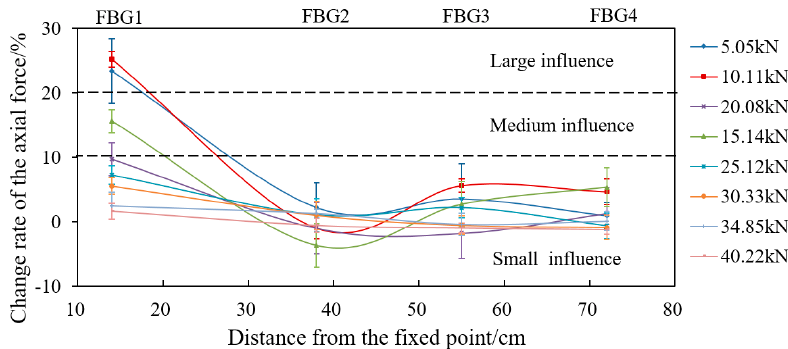
Figure 21. The variation curve of the change rate of the bolt-shaft axial force in “Passive”.